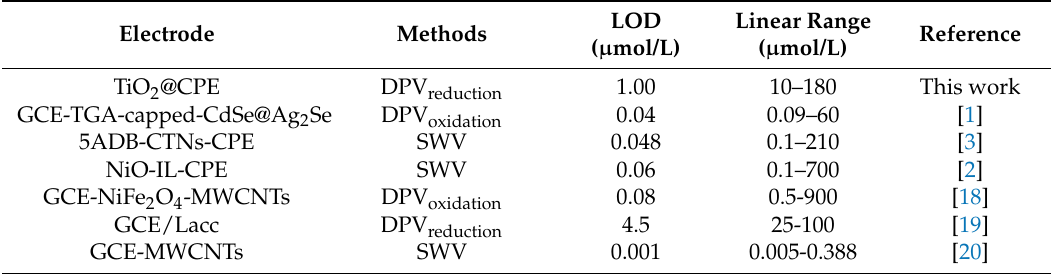
Table 3. Comparison of results obtained for methyldopa detection with different electrodes and the work done in this